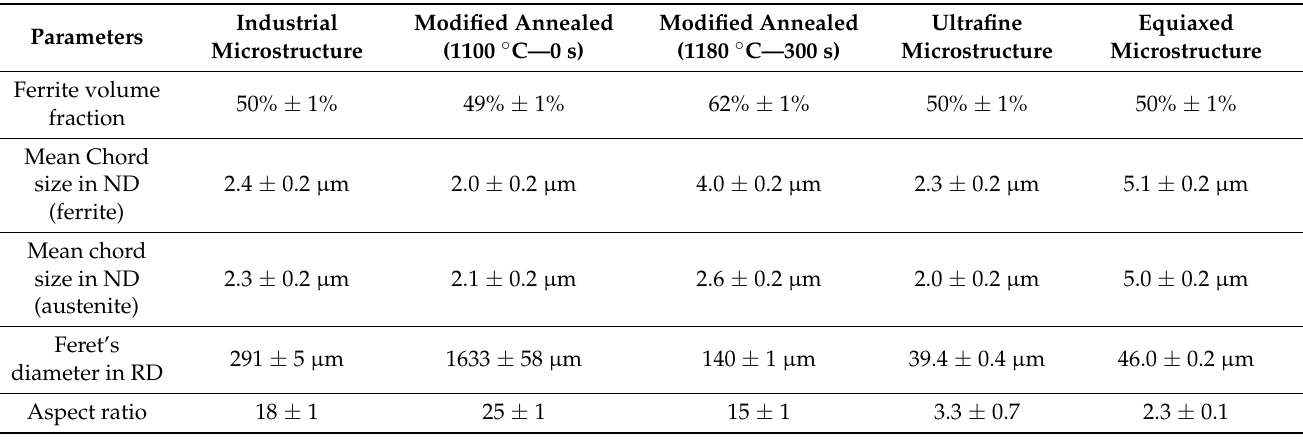
Table 2. Microstructures morphological characteristics of superduplex stainless steel.